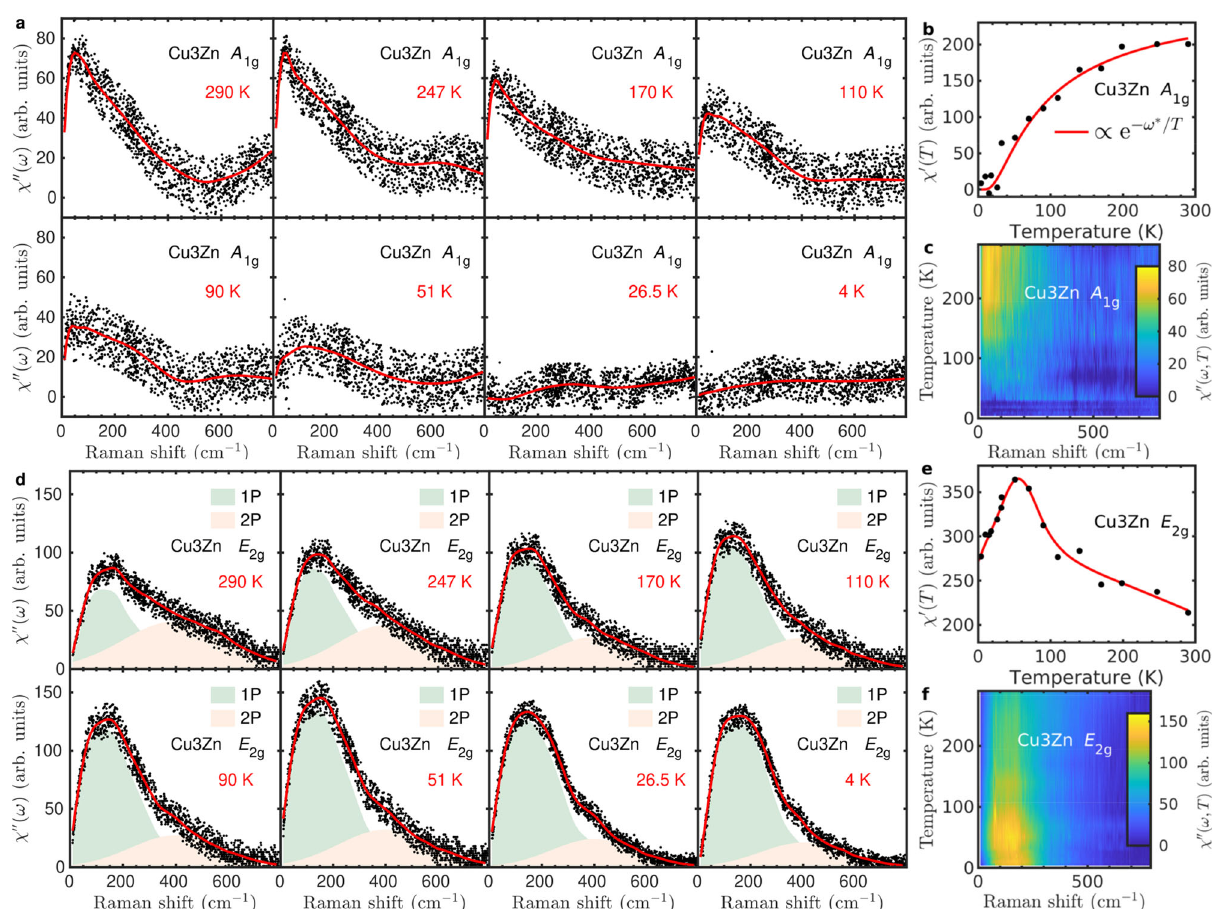
¼ χ 00 (cid:3) χ 00 . The solid lines are guides to the eye. XX XY 1g R χ 00 A ð ω Þ 400cm (cid:3) 1 ð T Þ ¼ 2 d ω . The solid line is a thermally activated function. c Color map 1g π ω 10cm (cid:3) 1 1g χ 00 ¼ χ 0 . The solid lines are guides to the eye. The light green and pink shadow marked as “ 1P ” and “ 2P ” E 2g XY